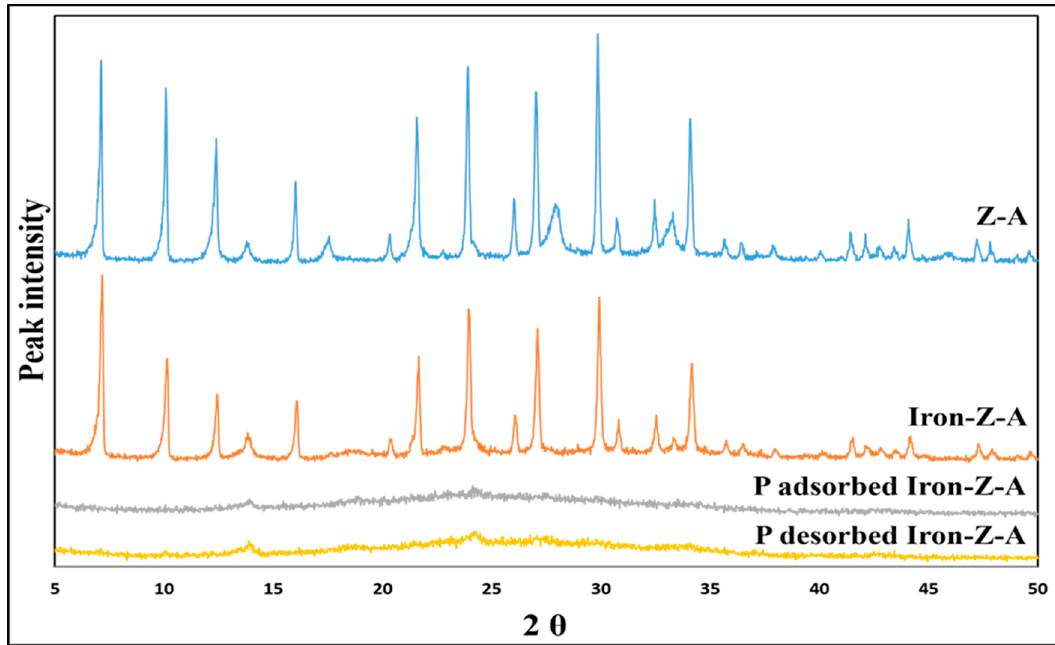
Figure 4. Illustration of XRD patterns of fresh Z-A, fresh Iron-Z-A, P-adsorbed Iron-Z-A, and P- desorbed Iron-Z-A.